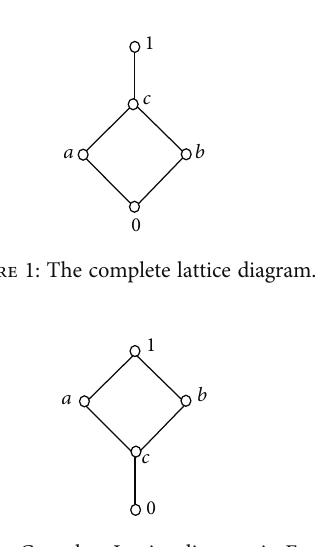
Figure 2: The Complete Lattice diagram in Example 5.